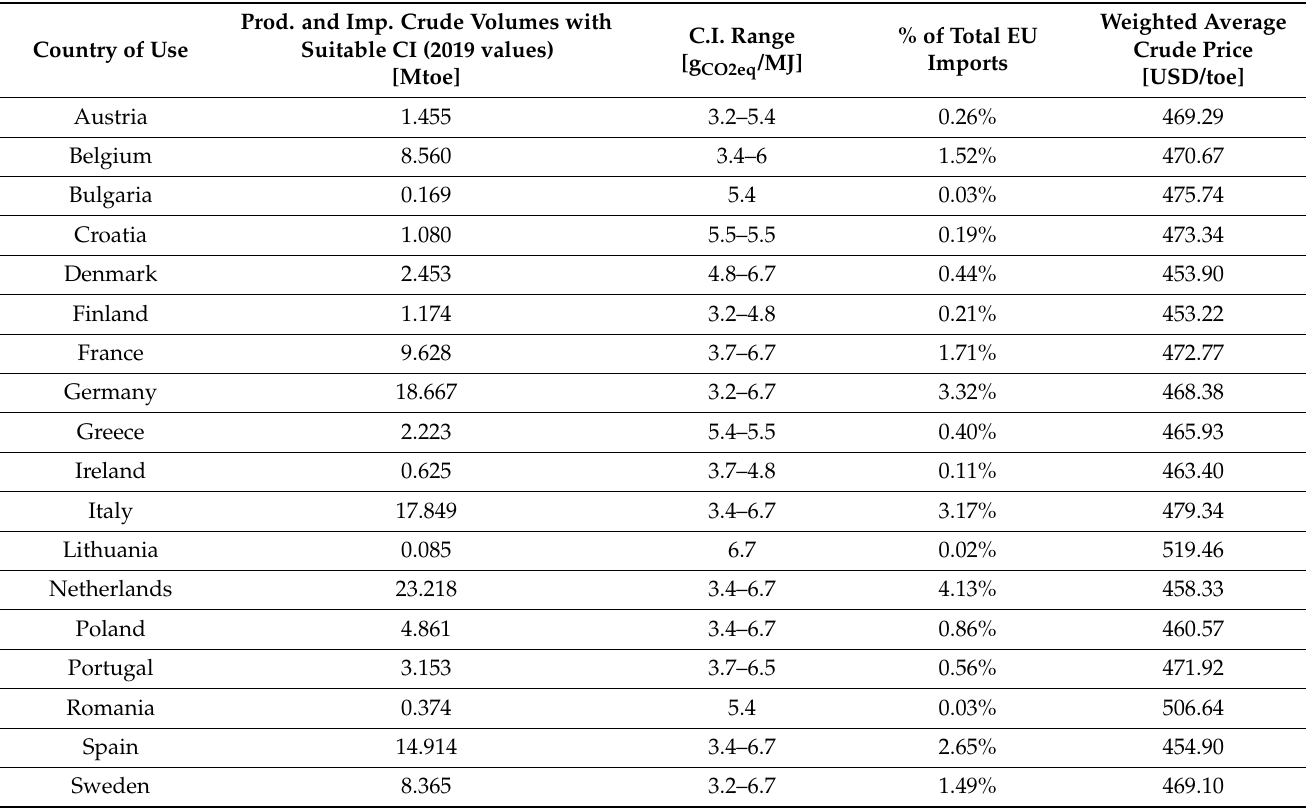
Table A3 provides the data reported as an EU-27 aggregate on Section 3.4.1 at country- level detail. In all the analysed scenario and for each considered Baseline Netherlands is the country which shows the higher LCAF deployment potential; when available, it ranges between 0.98 Mtoe and 3.14 Mtoe when considering Baseline A, and between 0.13 Mtoe and 1.76 Mtoe when considering Baseline B. The highest values are obtained at 2050, while at 2030 it is accounted for a potential ranging between 0.13 Mtoe and 1.22 Mtoe. France and Germany are the second more consistent countries, with potential ranging across 0.1 Mtoe and 0.9 Mtoe. Italy is also present, especially in the HIGH scenario, accounting for around 0.6 Mtoe of LCAF potential in both the considered